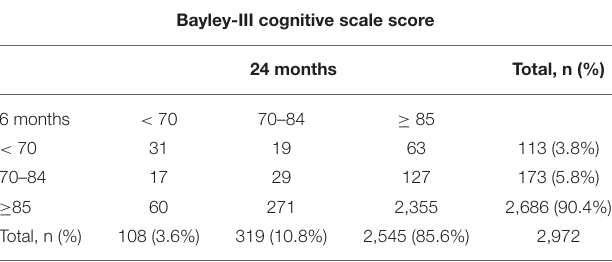
TABLE 1 | Rates of moderate delay ( < 70), mild delay (70–84), and normal cognitive scores ( ≥ 85) at 6 and 24 months of corrected age in 2,972 patients. Bayley-III cognitive scale score